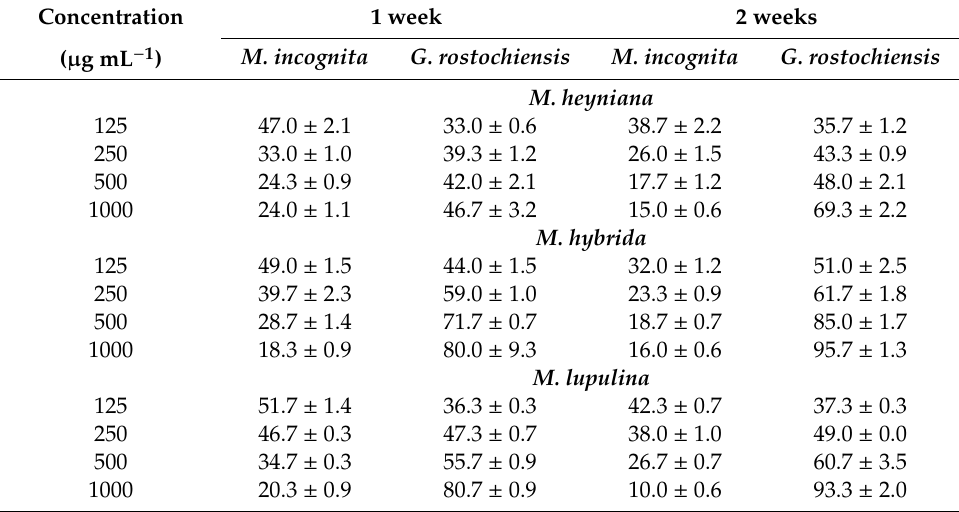
Table 7. Hatchability (%) of M. incognita and G. rostochiensis eggs after a 1- or 2-week exposure of